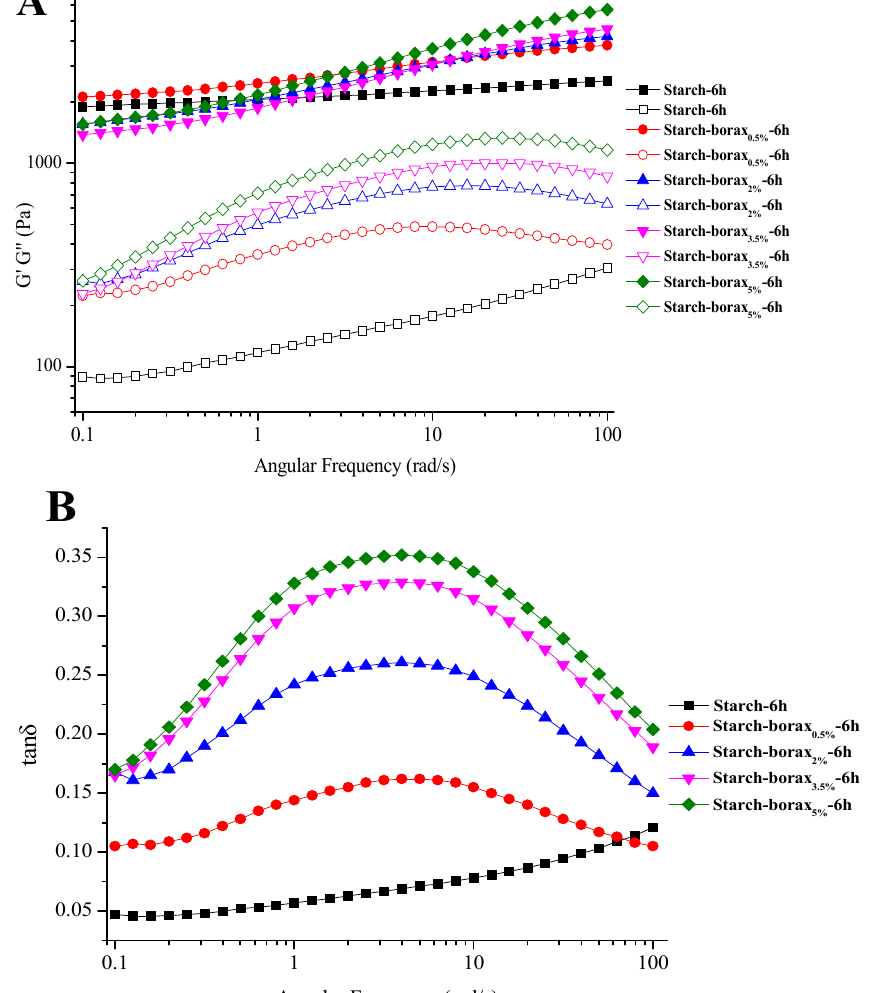
Figure 2. Frequency dependence of the G ′ (solid), G ″ (hollow), ( A ) and tan δ ( B ) values of starch– borax DC hydrogels with different content levels of borax, prepared at 4 °C for 6 h. Figure 3 shows the time sweep of the starch − borax DC hydrogels, upon cooling from 50 to 4 °C at a rate of 2 °C/min, and being maintained at 4 °C for 120 min. Upon cooling, the G ′ and G ″ values for all samples increased rapidly for 23 min. The values of G ′ and G ″ remained almost constant during the process of 4 °C for 120 min, indicating that starch– borax DC hydrogels were formed at 4 °C.